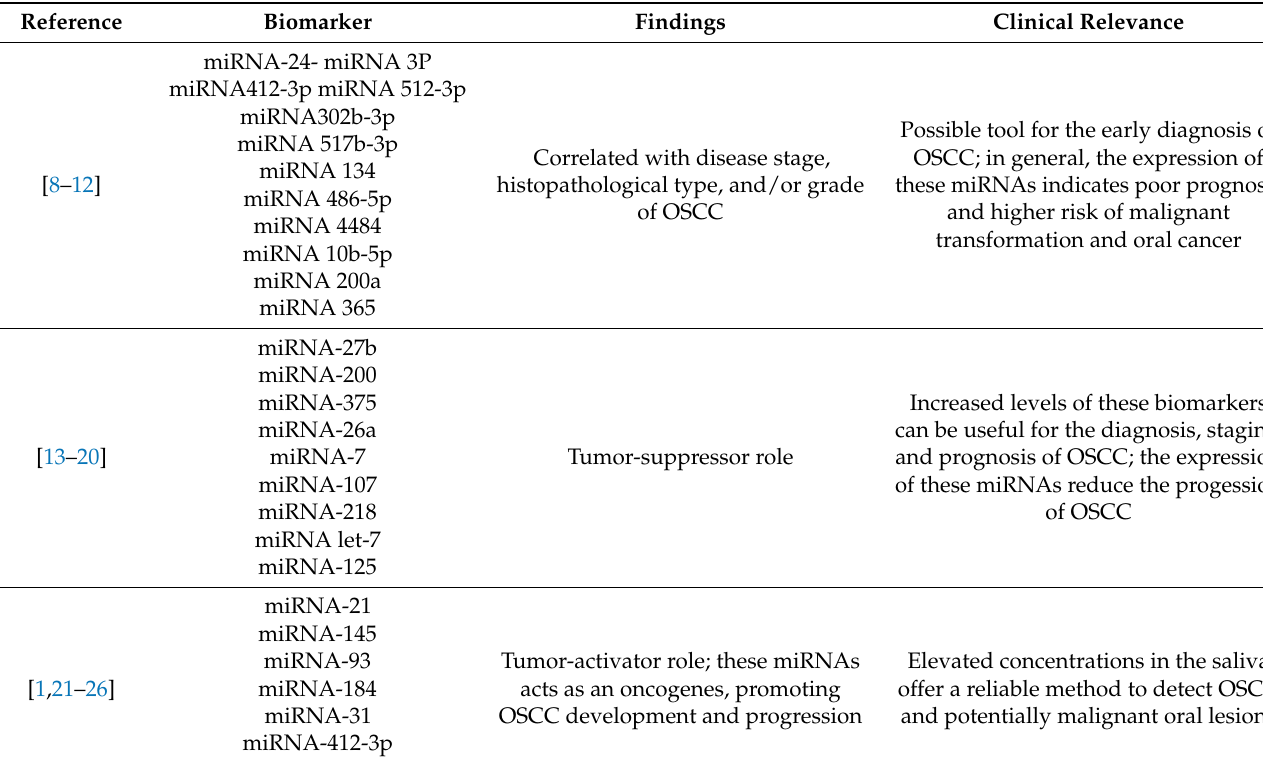
Table 1. Salivary microRNA related to diagnosis and prognosis of oral squamous cell cancer.